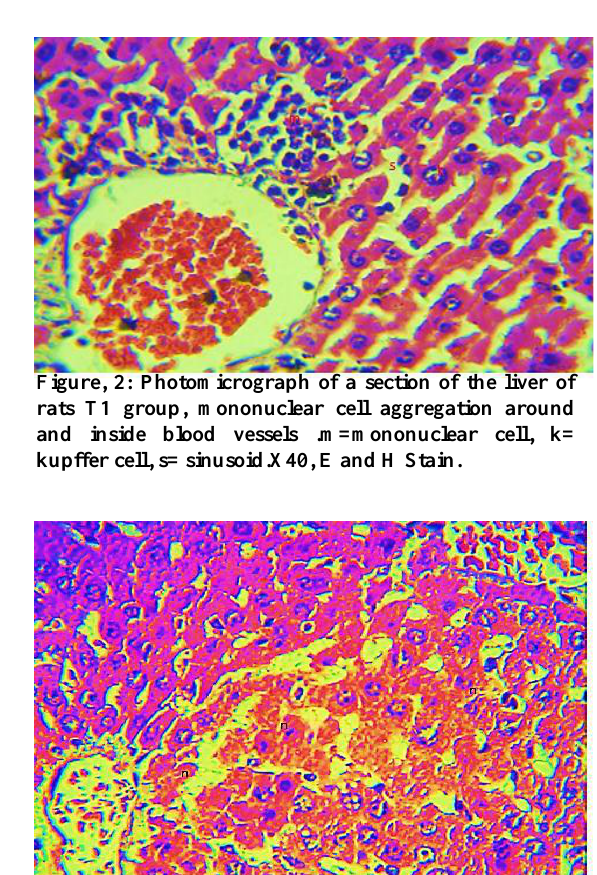
Figure, 4: Photomicrograph of a section of liver of rats T3 group showing central vein with focal necrosis and vaculation, n= necrosis, v= vacolation X40, E and H stain.